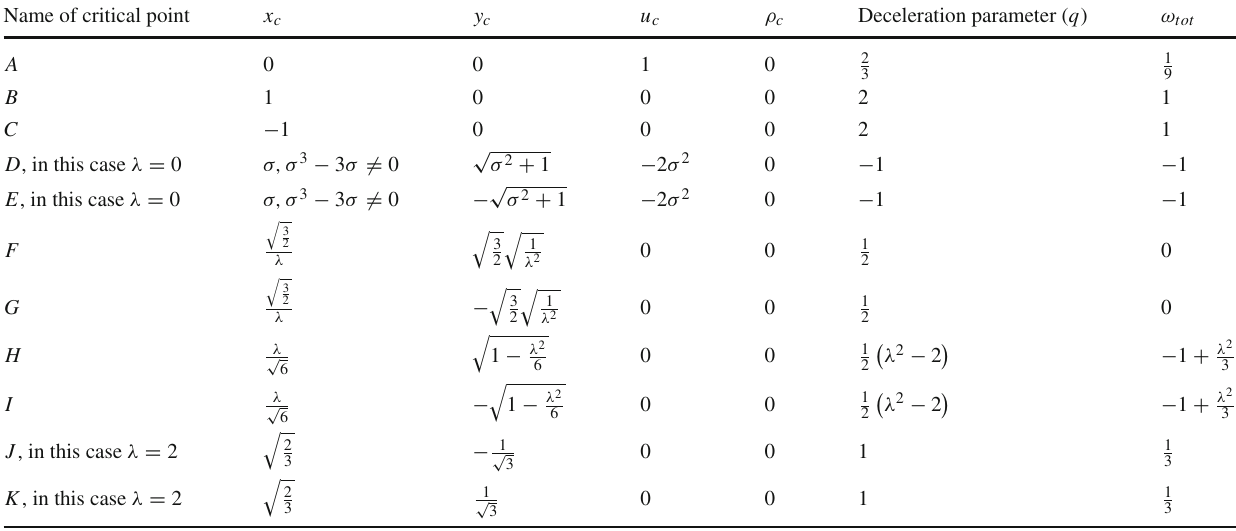
Table 11 Critical points for the dynamical system corresponding to updated calculations for Model-I Name of critical point